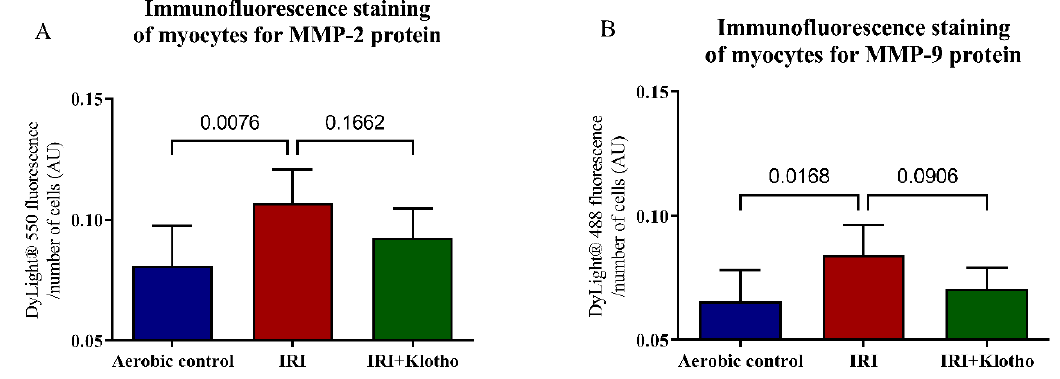
Figure 2. ( A ) Expression of the MMP-2 gene in human cardiomyocytes; n aerobic = 5; n IRI = 5; n IRI+Klotho = 5 ( B ) Expression of the MMP-9 gene in human cardiomyocytes; n aerobic = 14; n IRI = 14; n IRI+Klotho = 10. MMPs mRNA expression was examined by qPCR and normalized to G6PD expression; G6PD — glucose-6-phosphate dehydrogenase; MMP — matrix metalloproteinase; mean ±